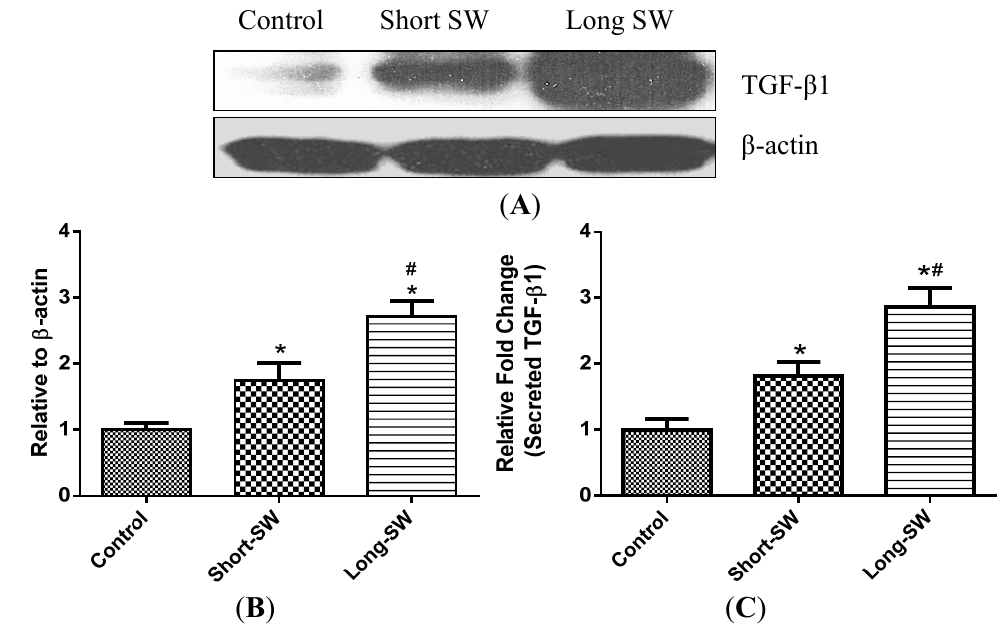
Figure 3. Effect of SWCNT fiber length on TGF- β expression. NHLF cells were exposed to 0.06 μ g/cm 2 of SWCNTs for 48 h. ( A ) Endogenous TGF- β levels in cell lysates were measured by Western blotting; ( B ) Relative TGF- β levels were quantified by Image J.; ( C ) Secreted TGF- β levels in the treated cell supernatants were measured by enzyme-linked immunosorbent assay (ELISA). Values are mean ± S.D. ( n = 3); * p < 0.05 vs. non-treated control; # p < 0.05 vs. Short-SW